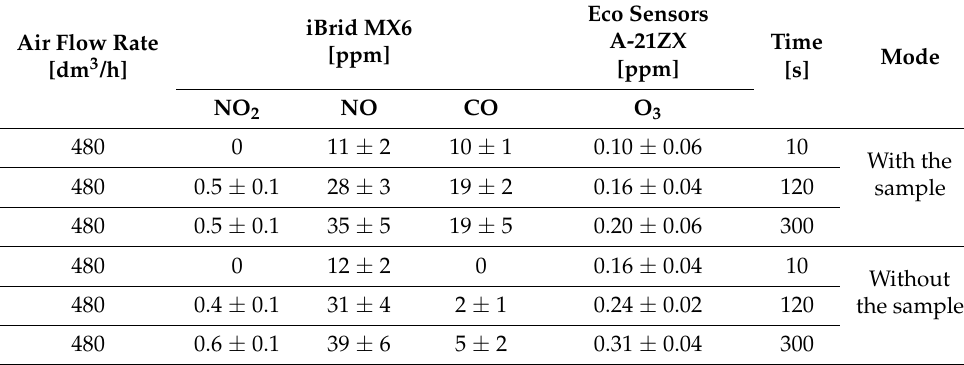
Table 4. Measured gases